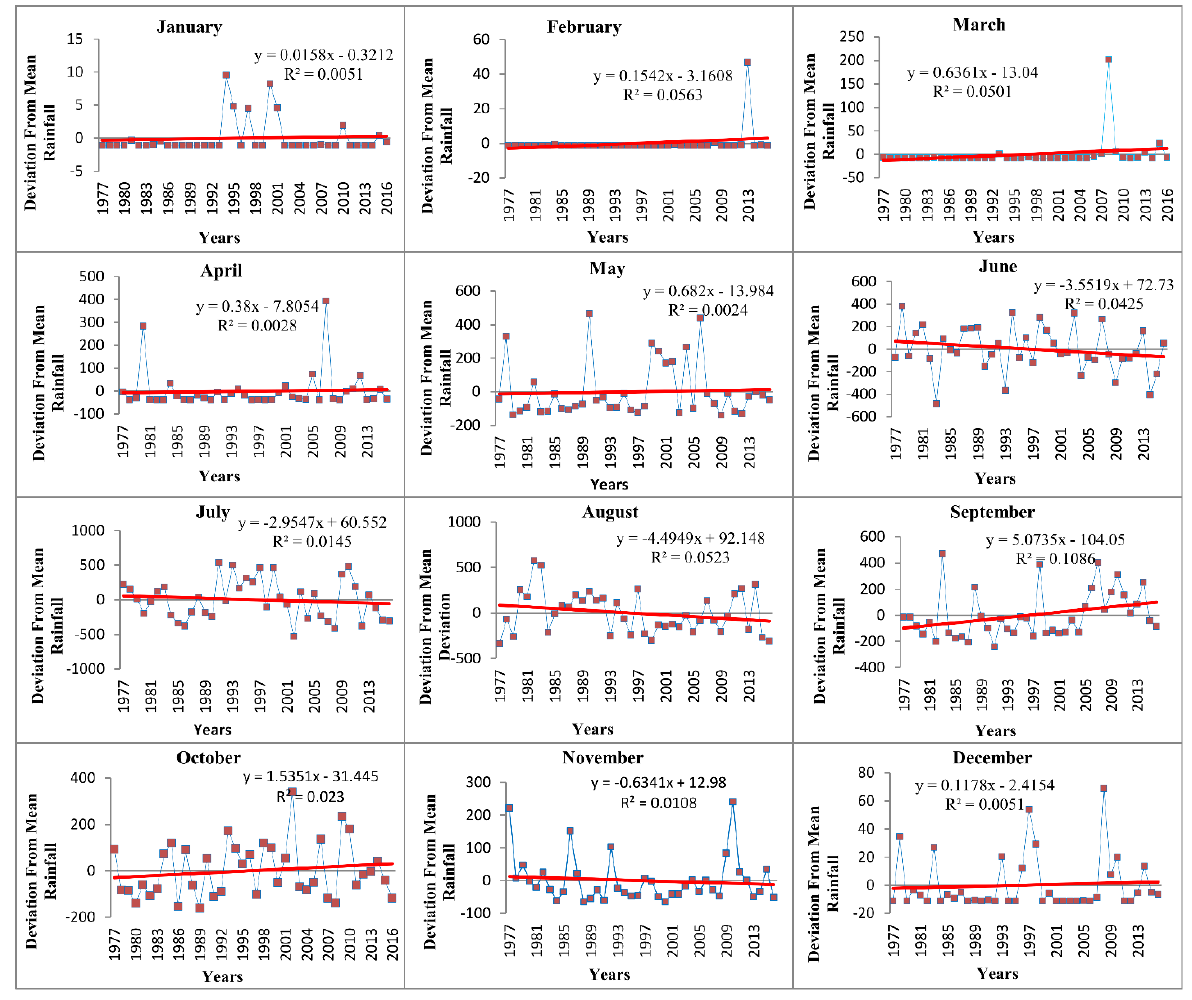
Figure 7. Monthly Rainfall Trends over Coastal